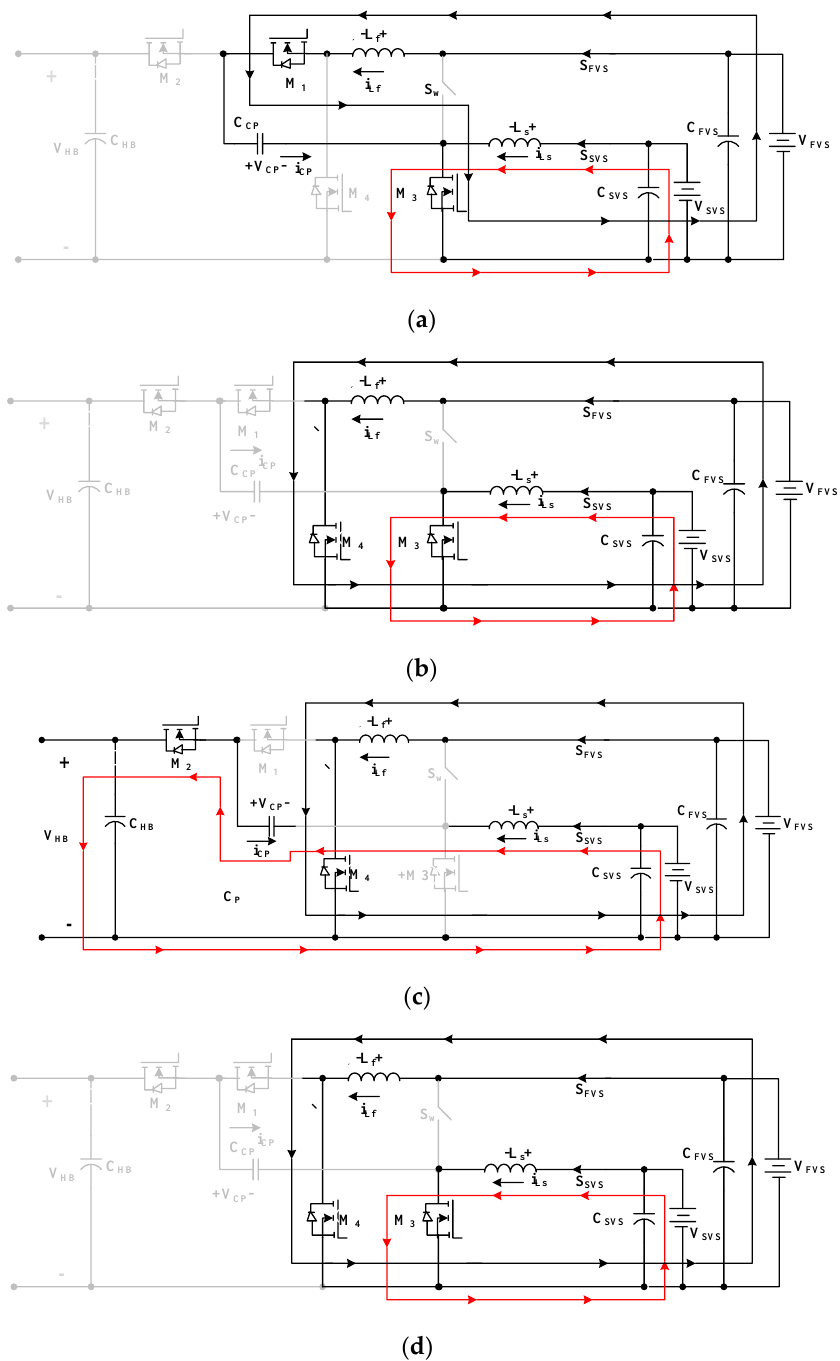
Figure 4. Circuit stages of BDC’s dual low-voltage sources powering mode.